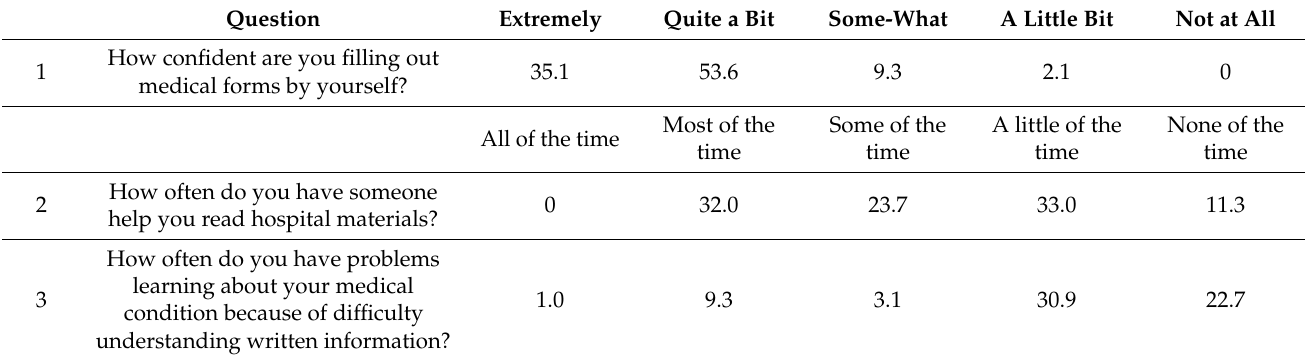
Table 2. Distribution of answers to the items of the BHLS scale (%), N =